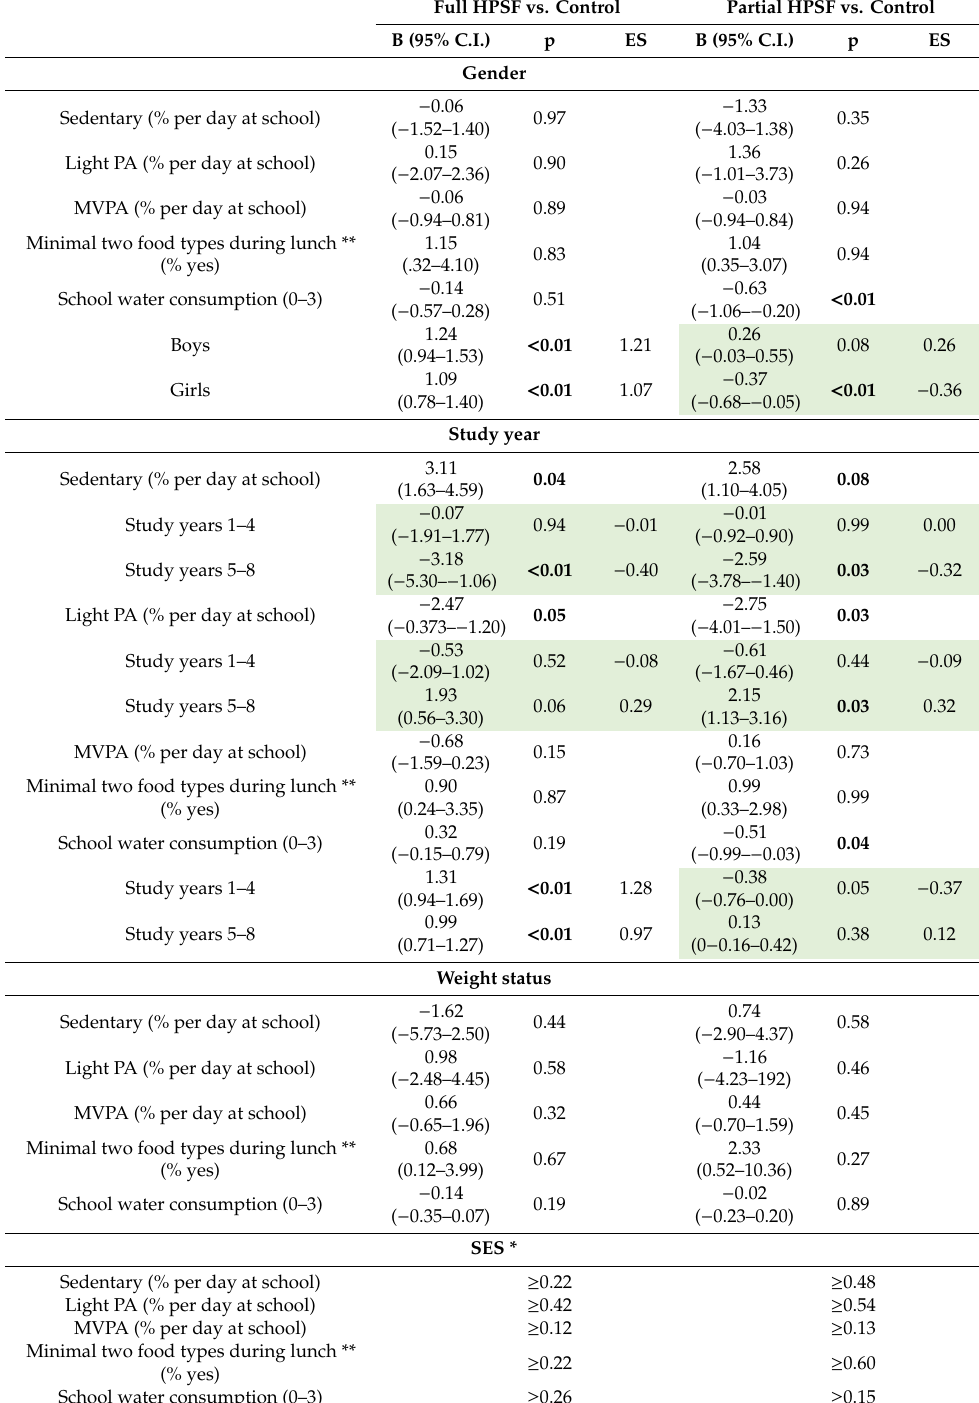
Table 3. E ff ect modifiers of HPSF on intervention e ff ects at